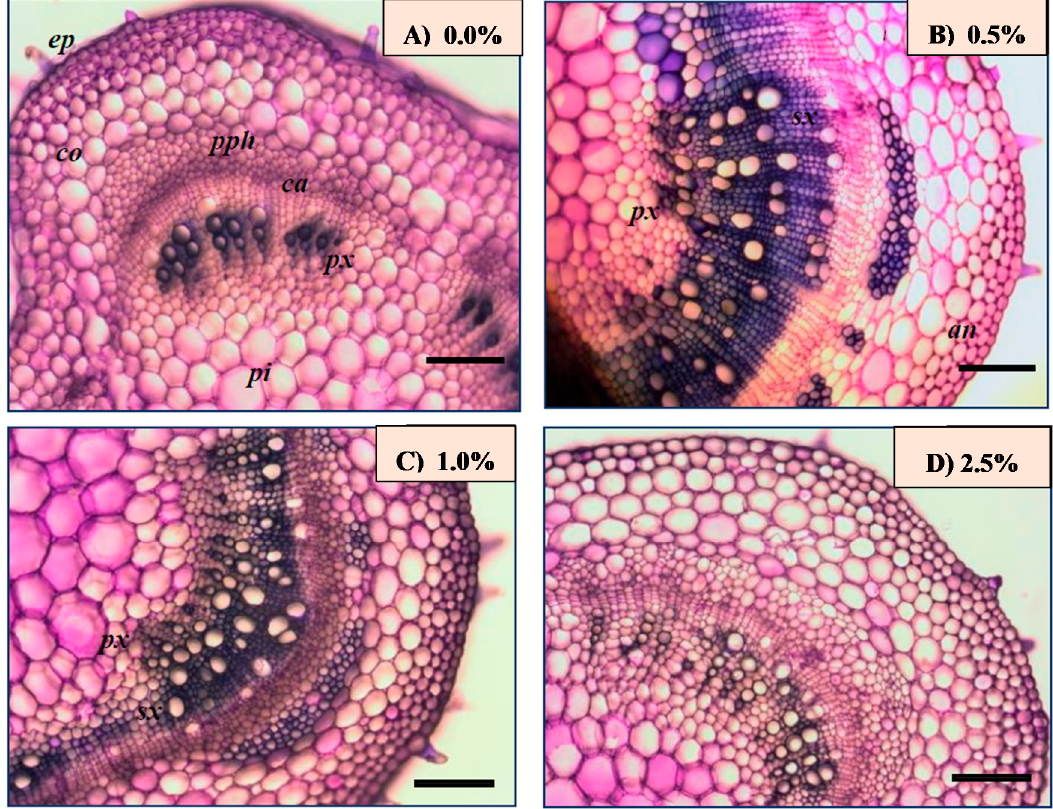
Figure 5. Anatomical sections of sweet basil stem. Subfigures show samples treated with